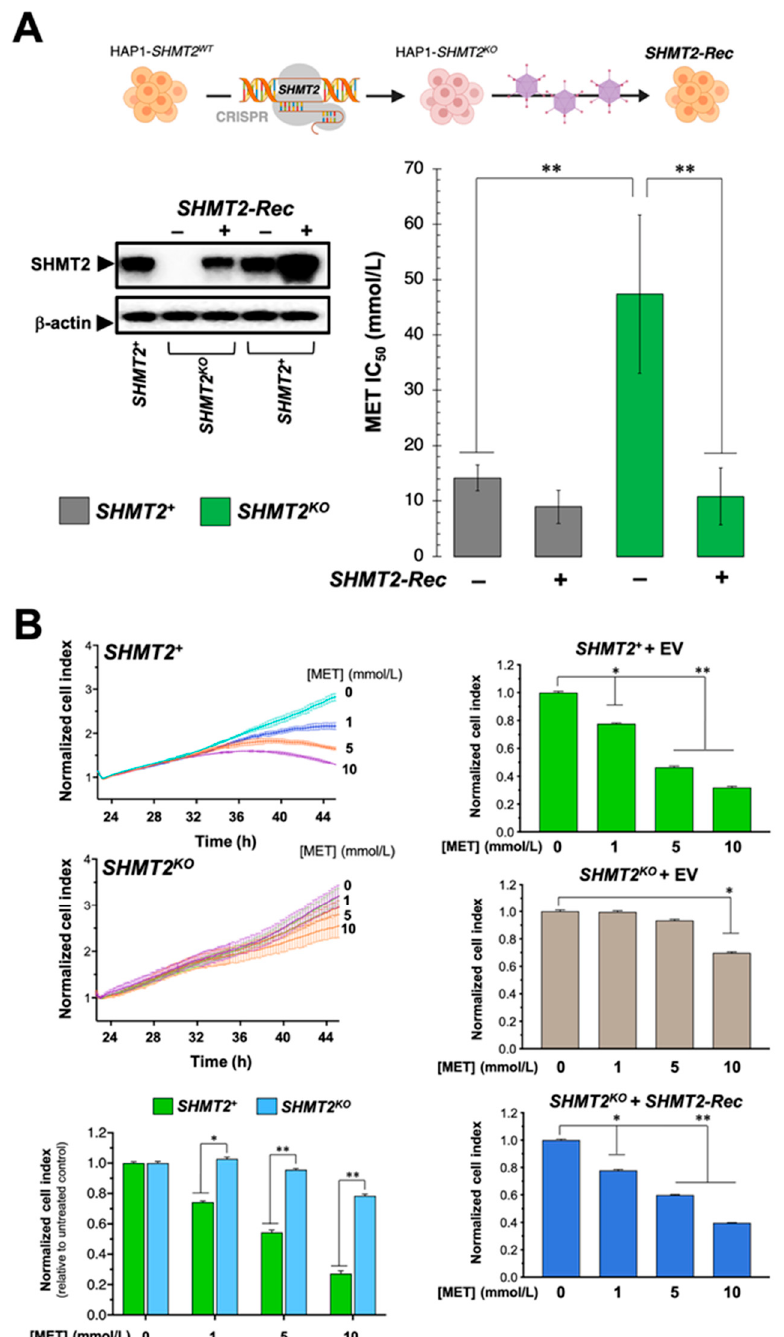
Figure 6. SHMT2 depletion prevents the cytotoxic and anti-proliferative effects of metformin. ( A ) Left. Representative immunoblot for SHMT2 or β -actin from cell lysates of HAP1 and SHMT2-KO HAP1 cell lines engineered to overexpress SHMT2 cDNA. Right. Bar graph showing MTT-based IC 50 values for metformin in HAP1 and SHMT2-KO HAP1 cells before and after re-expression of SHMT2. Columns are means and error bars are SD. n = 3 biological replicates in technical triplicates. ( B ) RTCA profiles and normalized cell indexes of HAP1 and SHMT2-KO HAP1 cells before and after re-expression of SHMT2 cultured in the absence or presence of graded concentrations of metformin (MET). Columns are means and error bars are SD. n = 3 biological replicates in technical triplicates. Comparisons of means were performed by ANOVA. p values < 0.05 and < 0.005 were considered to be statistically significant (denoted as * and **, respectively; n.s. not significant). EV: